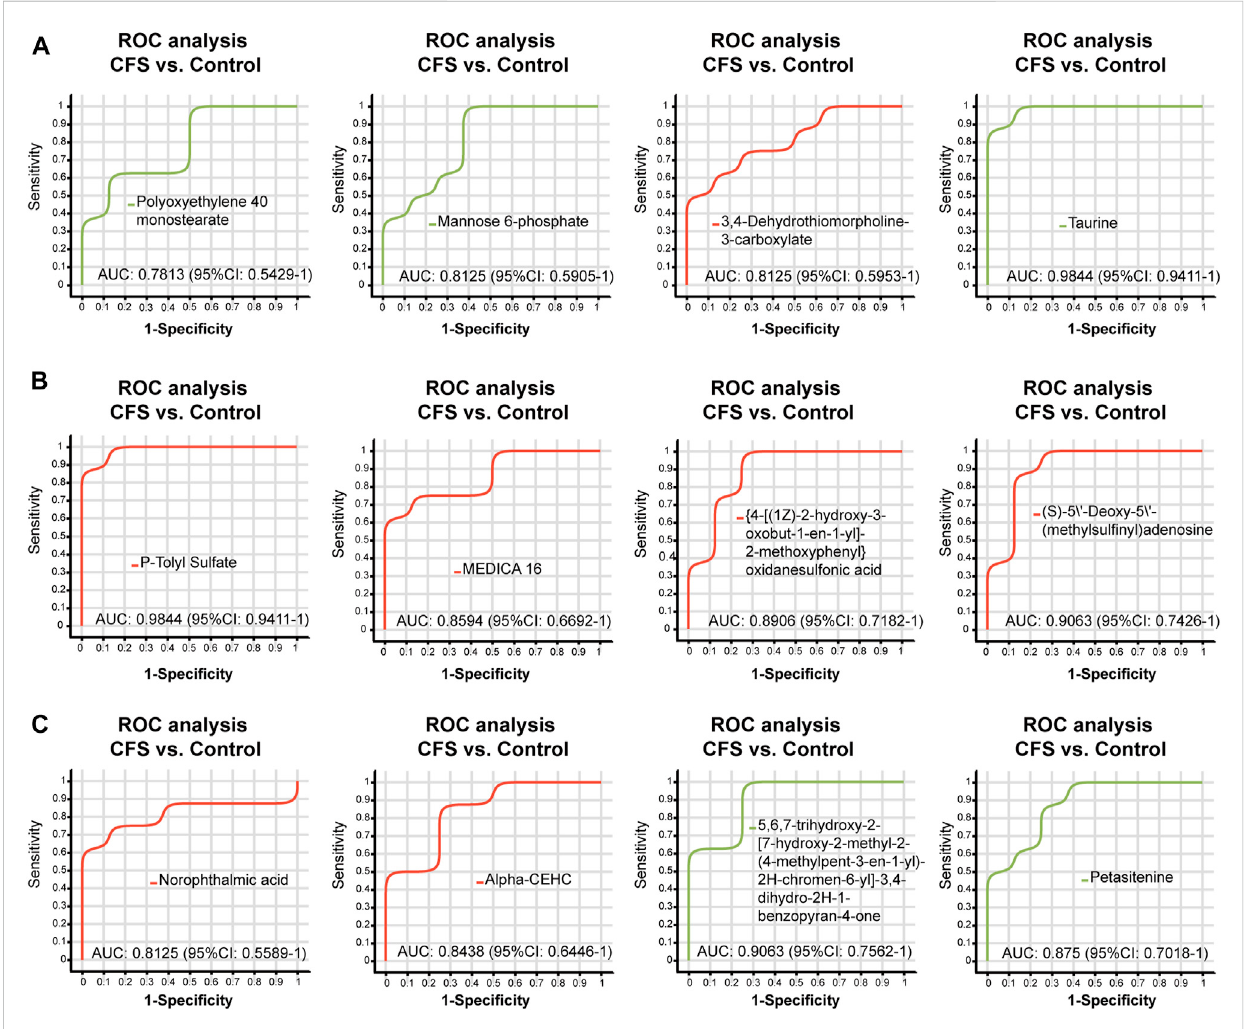
FIGURE 4 ROC curve analysis of differential metabolites (A – C) regulated by ginsenoside Rg1 (CFS vs. Control). The closer the AUC is to 1, the better the diagnostic prediction. AUC has low accuracy between 0.5 and 0.7, and high accuracy above 0.7.